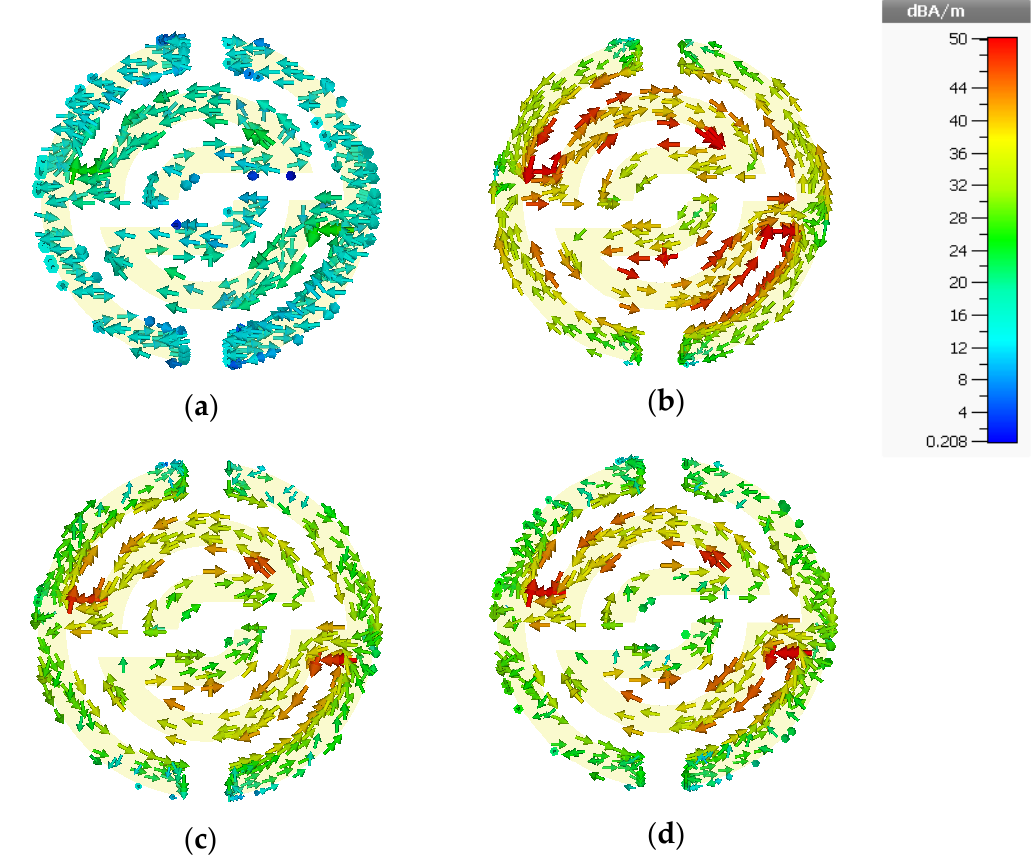
Figure 3. Surface current distribution at ( a ) 3.5 GHz, ( b ) 10.3 GHz, ( c ) 11 GHz, and ( d ) 11.9 GHz.